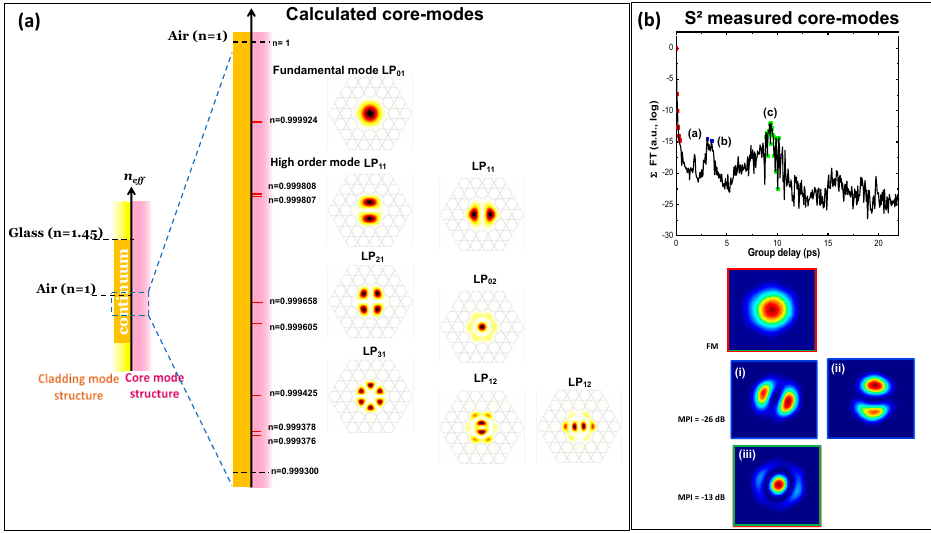
Figure 22. ( a ) lhs : Typical core mode profiles of a Kagome IC-HCPCF and their location in the n eff -space. ( b ) A Kagome HCPCF S 2 measured trace and the intensity profiles of the retrieved modes around 1 µm.